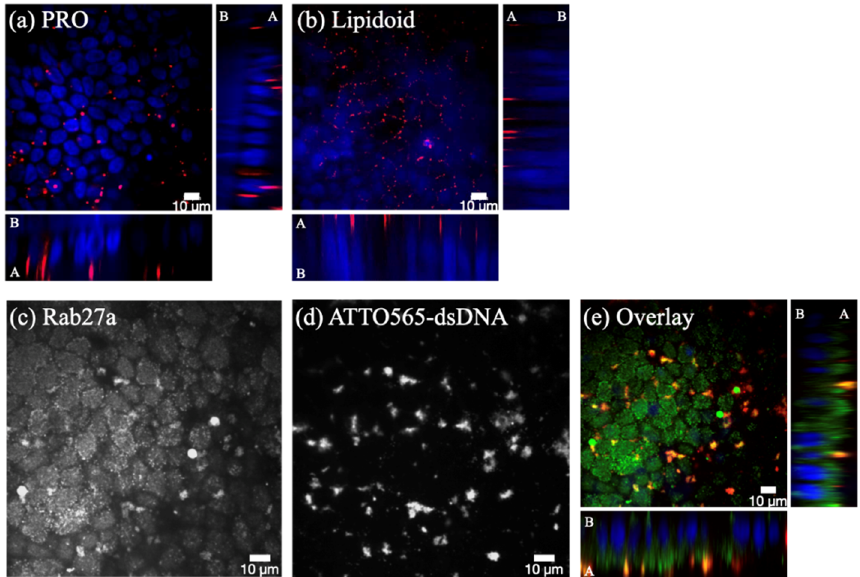
Figure 9. Intracellular distribution of ATTO565-labelled dsDNA (in red) in 4-week matured hESC-RPE. dsDNA (50 nM) was incorporated into the commercial carrier Metafectene PRO ( a ) and into the lipidoids ( b ). ( c – e ) Intracellular distribution of Metafectene PRO / dsDNA (50 nM) complexes in 4-week matured hESC-RPE. ( c ) Melanosomes were identified with Rab27a antibody; ( d ) ATTO565-labelled dsDNA; and ( e ) overlay image where melanosomes are in green, dsDNA in red, and cell nuclei in blue (DAPI). A: apical side; B: basolateral side. Scale bar: 10 µm.